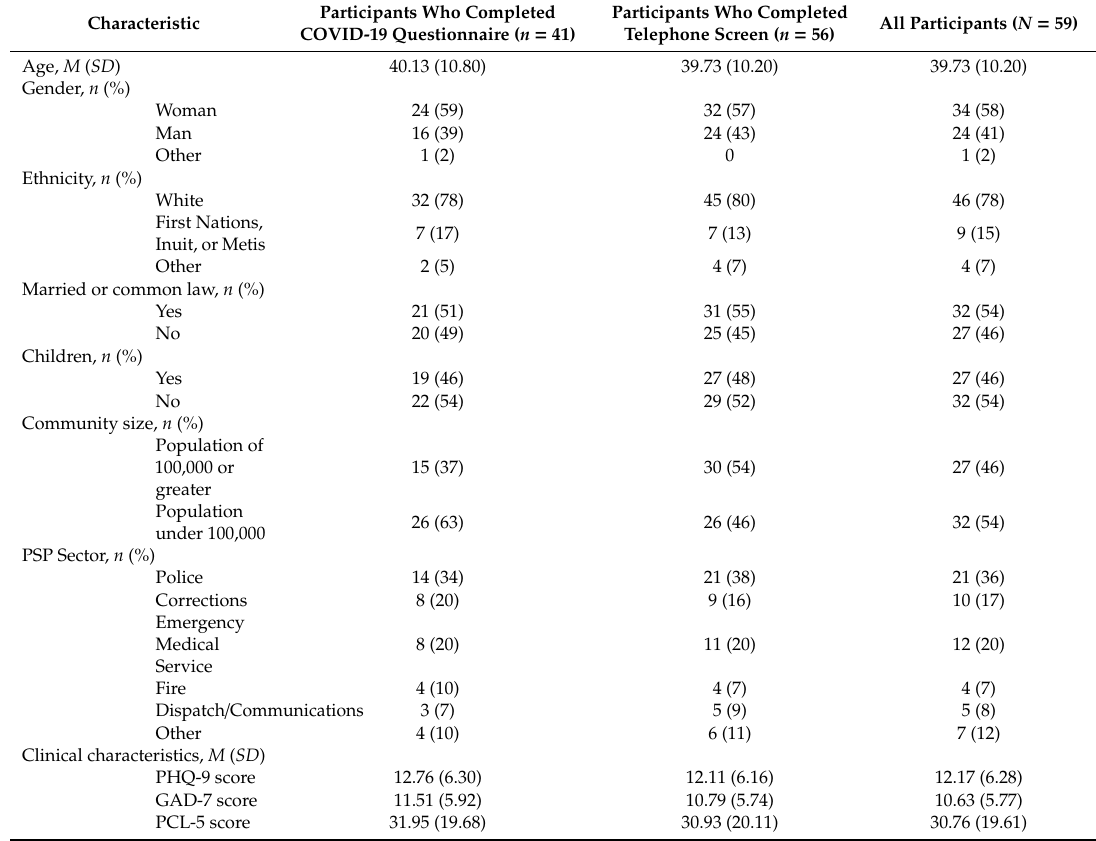
Table 1. Participant